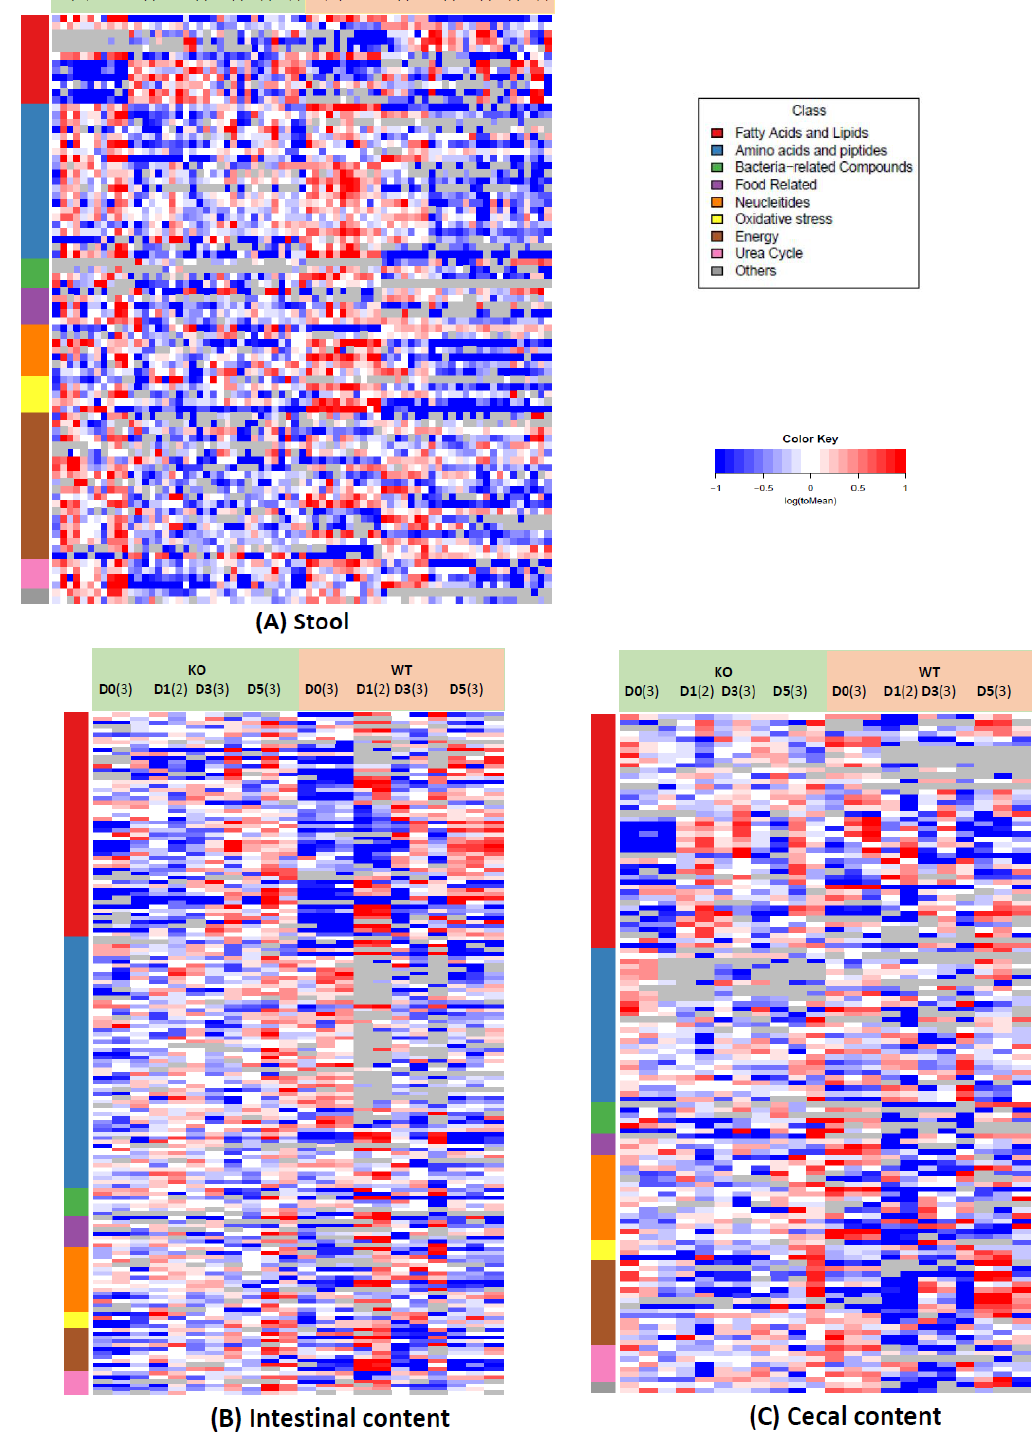
Figure 2. Untargeted metabolomics of the gut metabolome. Heat maps of log e transformed